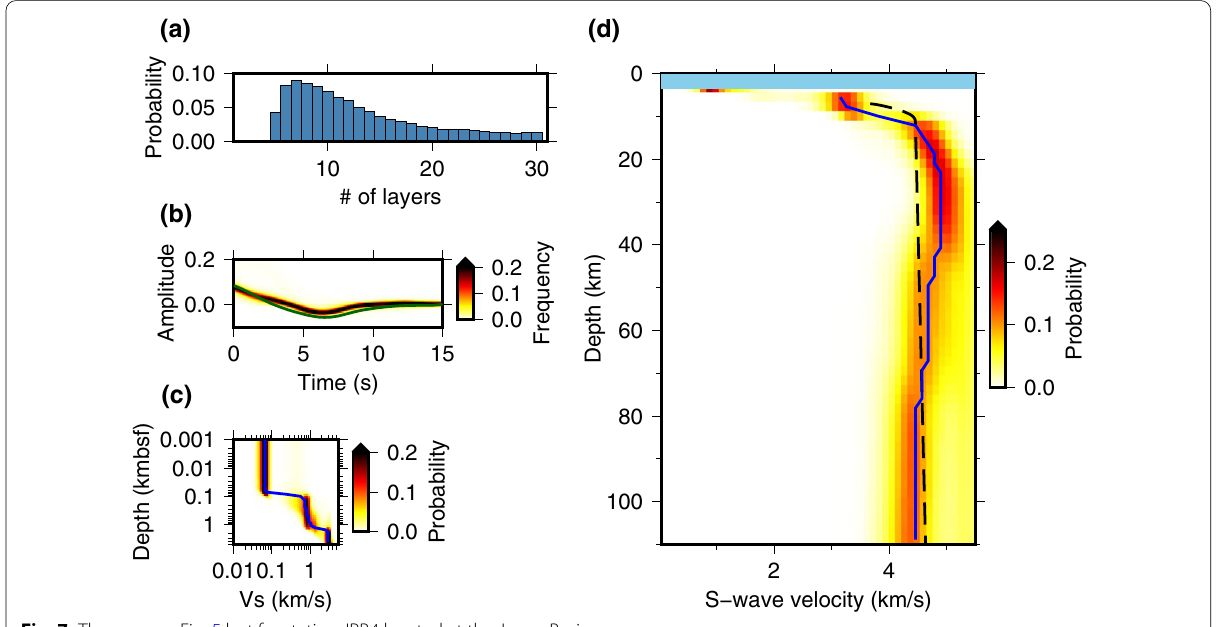
Fig. 7 The same as Fig. 5 but for station JPB4 located at the Japan Basin